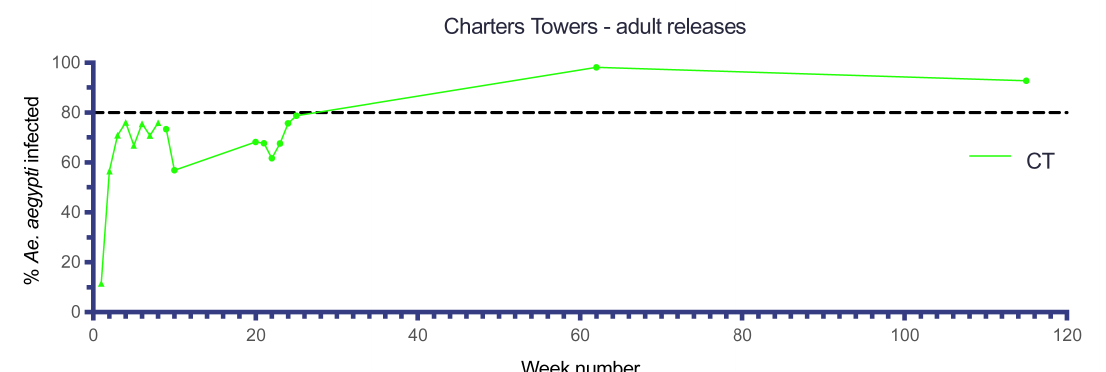
Figure 11. Wolbachia infection rates in Aedes aegypti mosquitoes collected from Charters Towers (CT), during release (triangles) and post-release (circles) monitoring periods ( Wolbachia infected adult releases were undertaken every week for 8 weeks between Oct–Nov 2016, Week number 1 corresponds to commencement of Wolbachia mosquito releases).